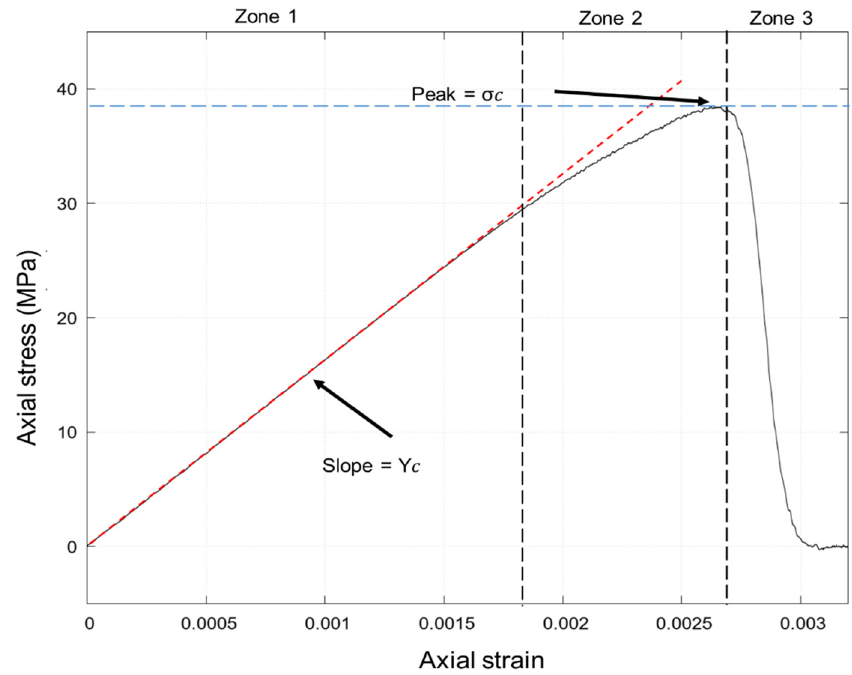
Figure A2. Axial stress vs. axial strain and curves for a typical uniaxial compression simulation with an illustration of the calculated Young’s modulus and unconfined compressive strength.